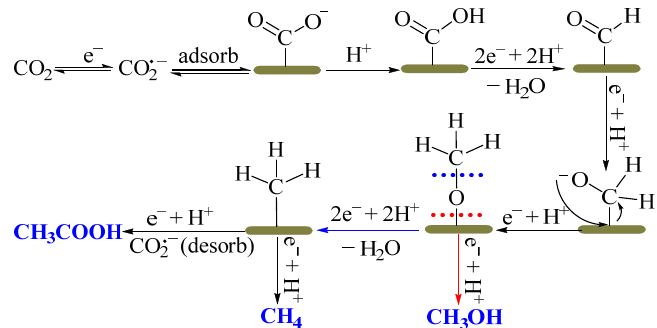
Figure 9. Probable mechanism of CO 2 RR with product distribution over intermetallic nano-alloys [104]. Reproduced with permission from Ref. [103]. Copyright © 2023, American Chemical Society.